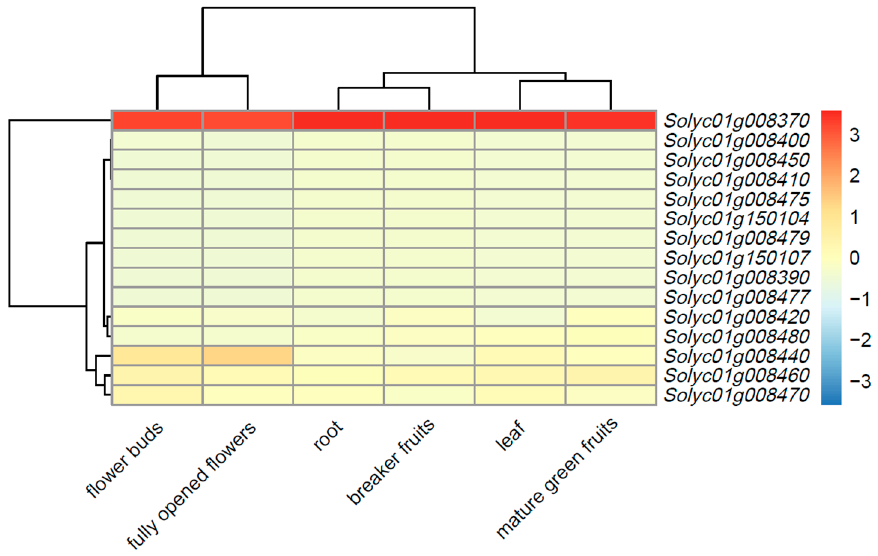
Figure 3. Heat map of expression profiles in different tissues of Heinz tomato of the genes within 50 kb upstream and downstream of TGS377. 50 kb upstream and downstream of